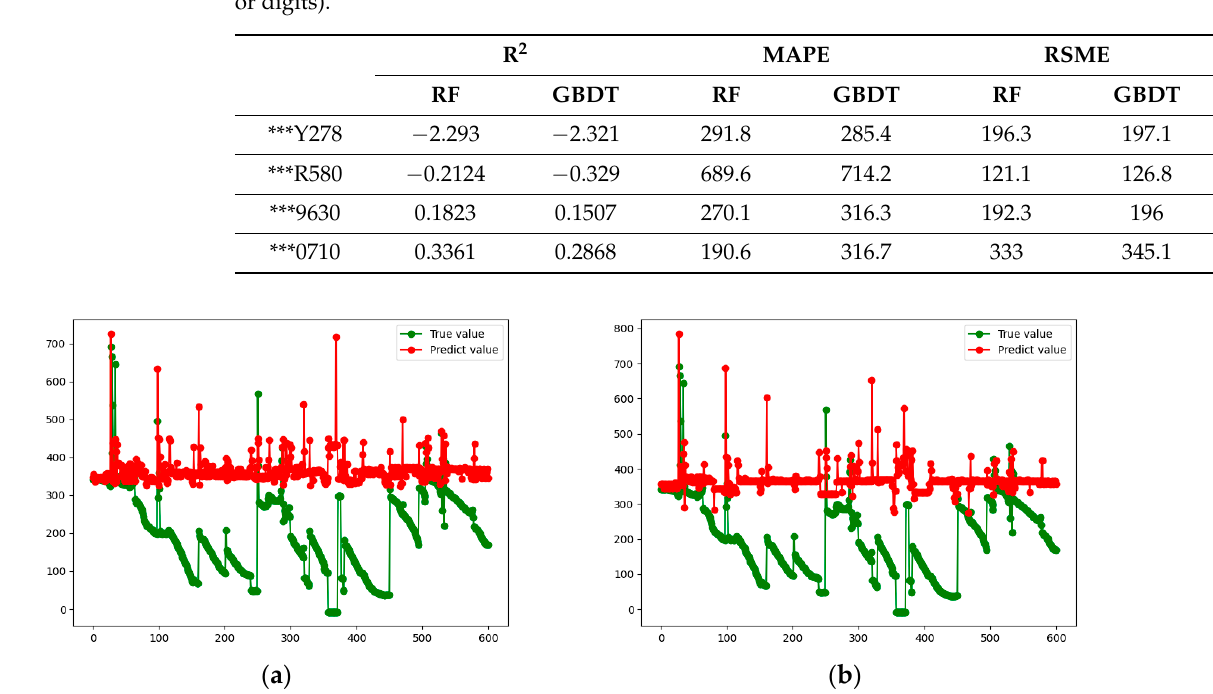
Figure 8. The prediction results by RF ( a ) and GBDT ( b ) for the vehicle of ***Y278.